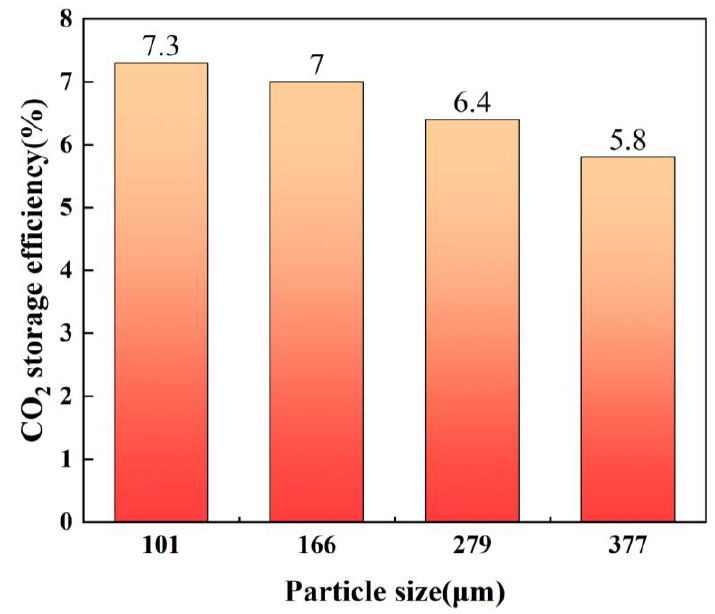
Figure 5. Storage efficiency of CO 2 in the replacement reaction in Experiments 1, 2, 3, and 4.